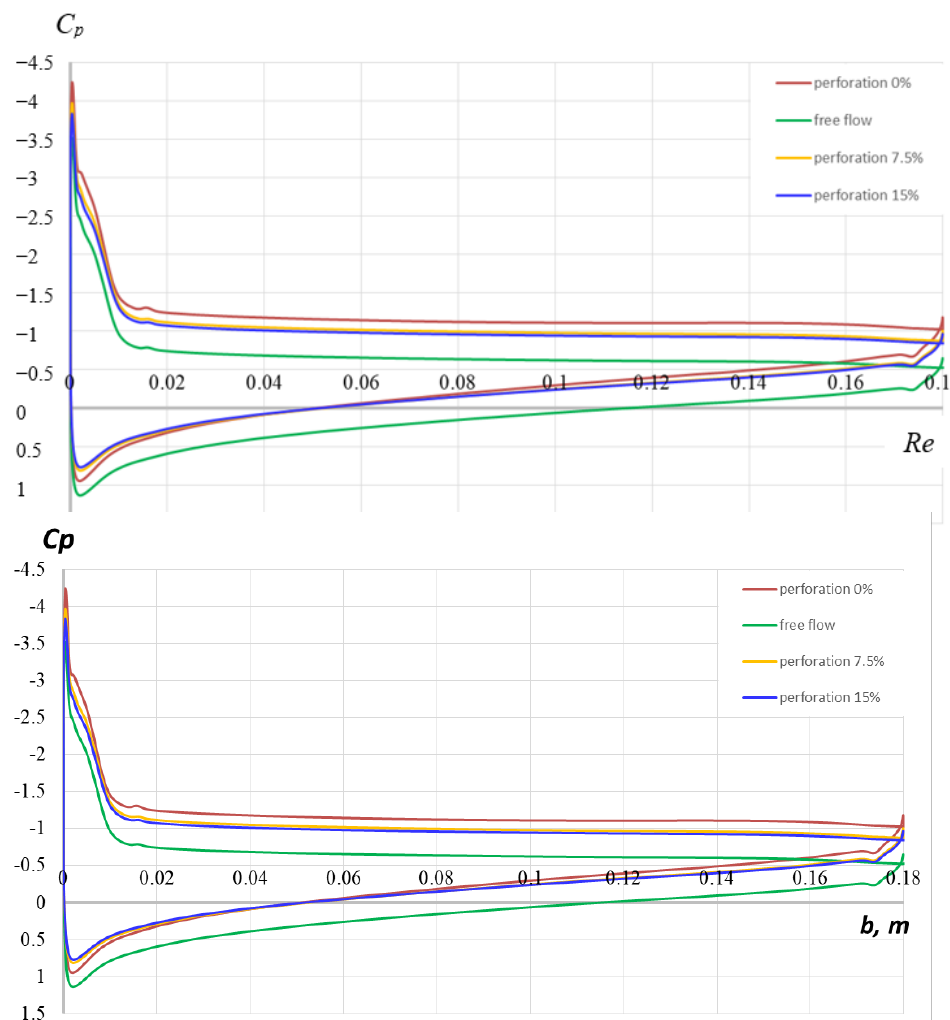
Figure 6. Calculated dependences of the pressure coefficient for various variants of perforation of ADT walls and for the case of free flow around the airfoil (α = 16°).